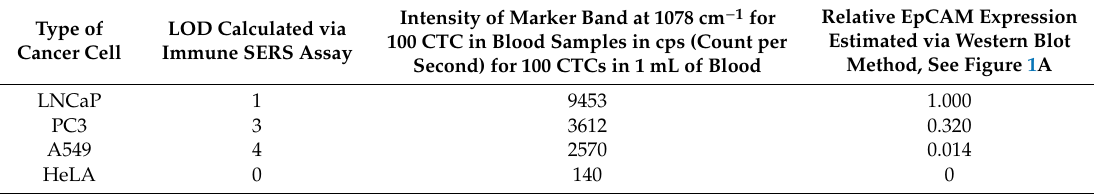
Table 1. Data obtained in SERS immune assay in comparison to Western Blot